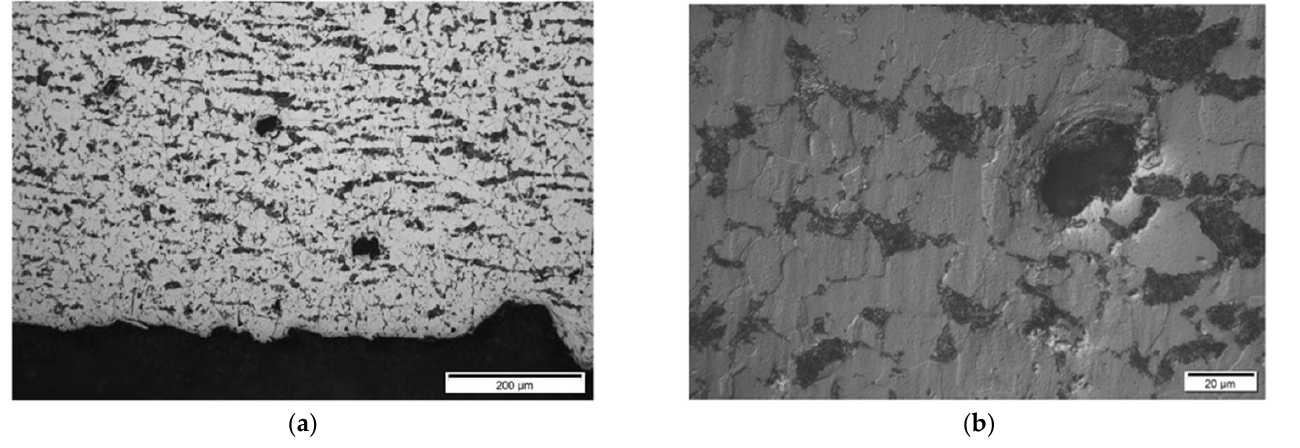
Figure 21. Section No1: 60–88. Coordinate 70 mm, isolated HIC blisters, micro deformation in dis- continuity area, magnification 200× ( a ), 1000× ( b ).